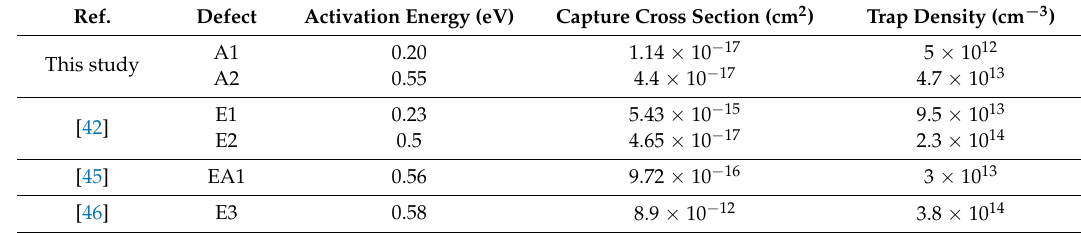
Table 1. Defect parameters for Au/a-plane GaN Schottky diodes. Ref.